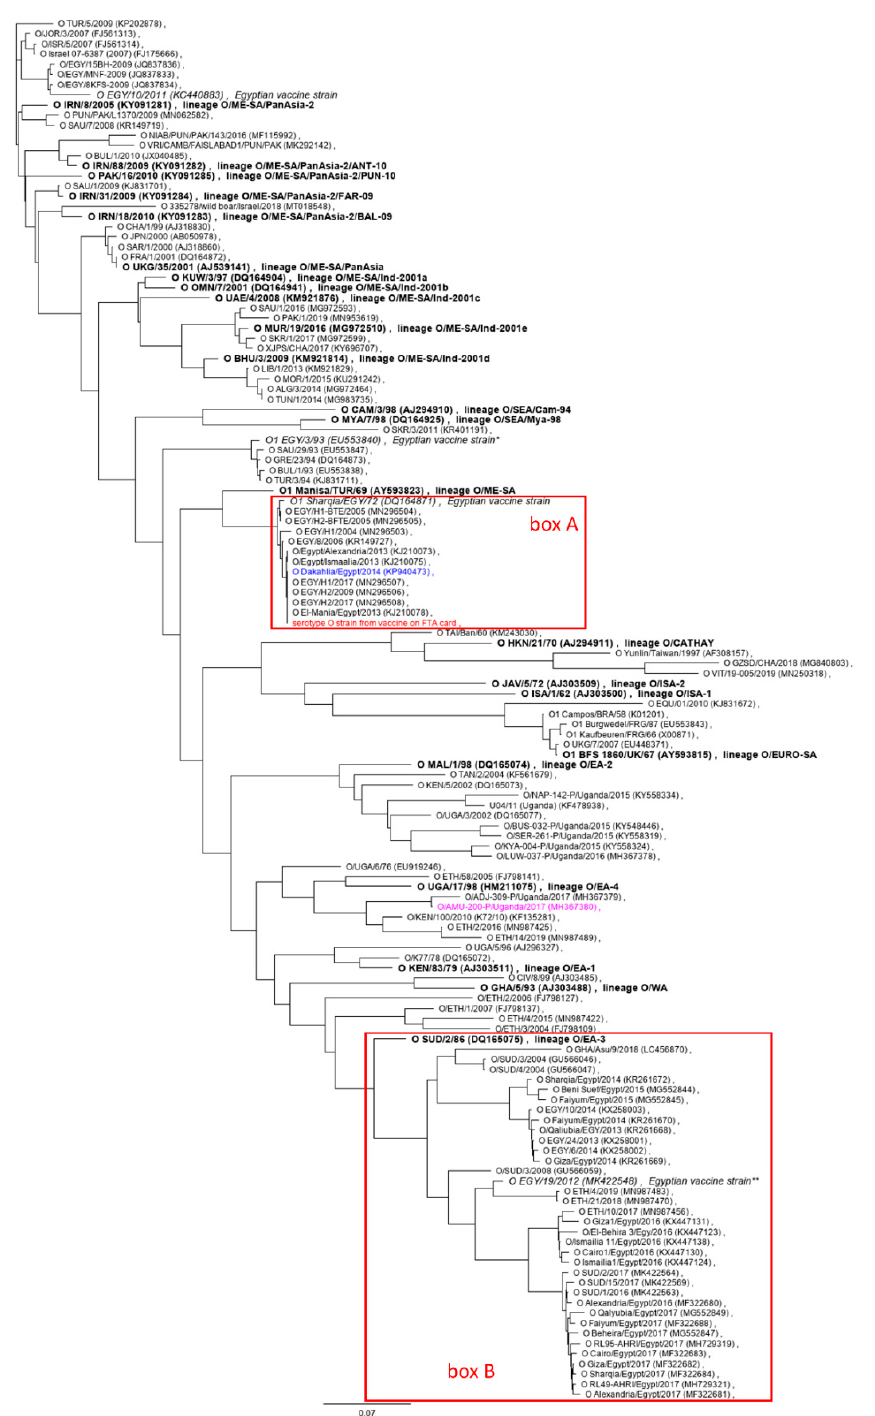
Figure 4. Serotype O 1D (VP1) phylogeny. The serotype O vaccine strain recovered from the FTA